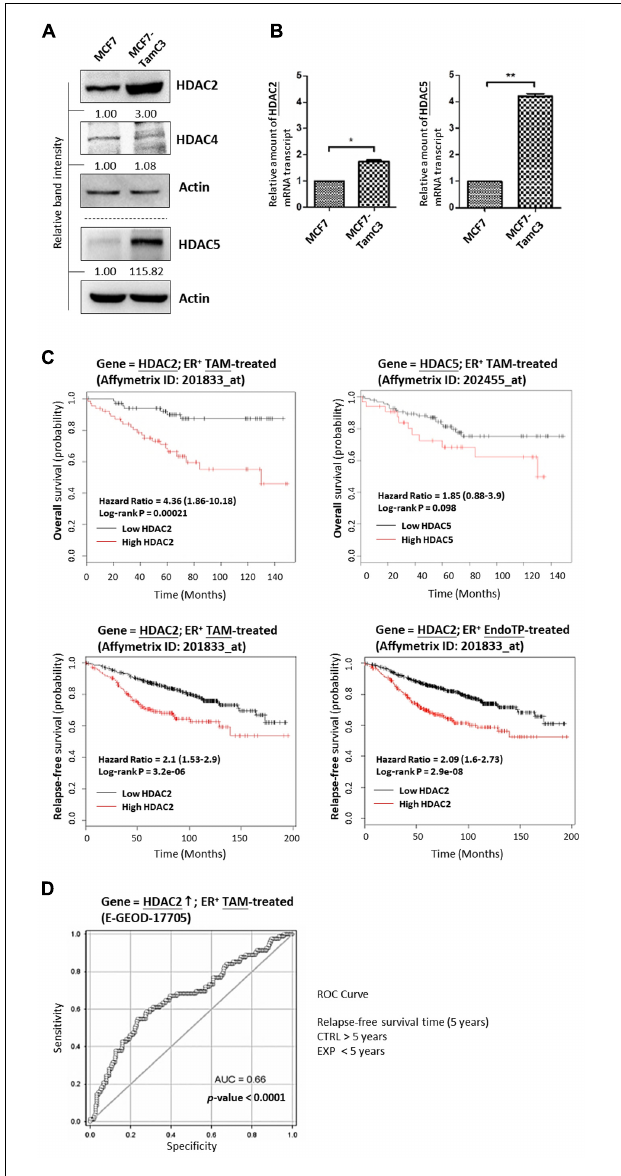
FIGURE 1 | Upregulation of HDAC2 correlates with poor overall and relapse-free survival in patients with ER + , hormone therapy-treated breast cancer. (A,B) Expression of various HDAC isoforms in MCF7 and MCF7-TamC3 cells was determined by Western blotting and qPCR analysis. Both “ ∗ ” and “ ∗∗ ” denote a statistical significance ( P < 0.05 and P < 0.01, respectively) between the testing groups. (C) Kaplan–Meier survival estimates of high (red line) or low (black line) HDAC2 and HDAC5 expression in ER + tamoxifen/endocrine therapy-treated breast cancer. Analysis was performed using the online database and web tool (Kaplan Meier plotter). (D) ROC analysis of HDAC2 for 5-year relapse-free survival on ER + tamoxifen-treatment breast cancer